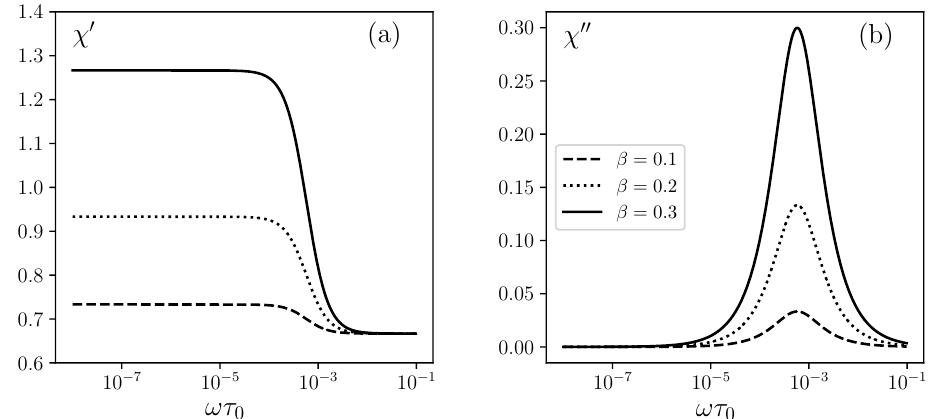
Figure 2. Frequency dependence of the: ( a ) real χ (cid:48) and ( b ) imaginary χ (cid:48)(cid:48) parts of the magnetic susceptibility of an antiferromagnetic particle ensemble with a random distribution of the anisotropy axes; the decompensation parameter β is: 0.1 (dashes), 0.2 (dots), 0.3 (solid lines); the temperature parameter σ = 10.